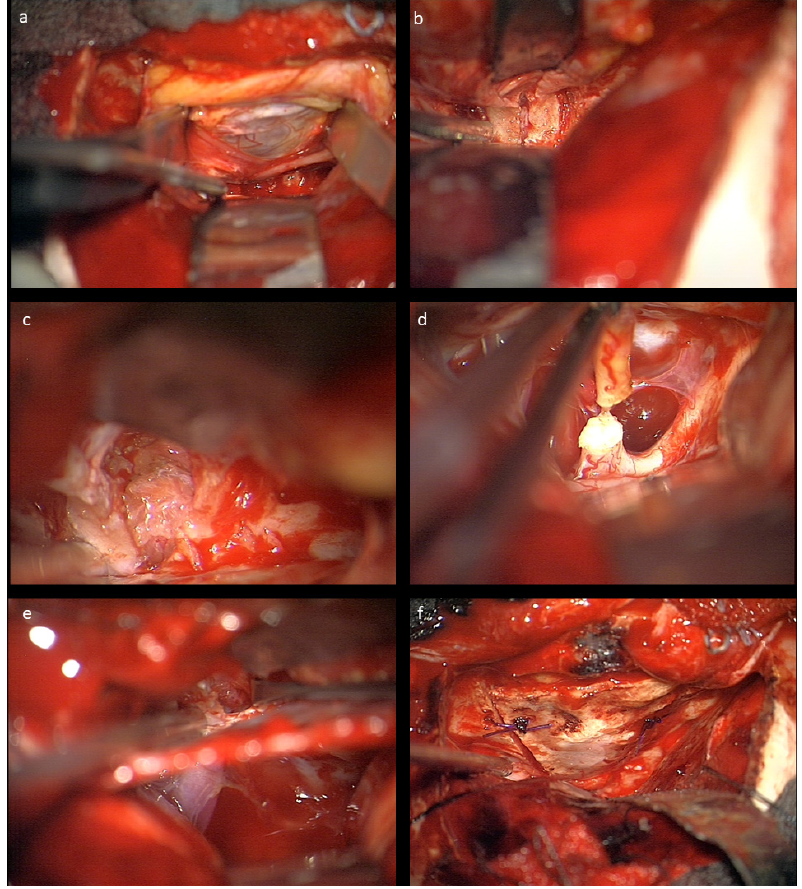
Figure 2. Intraoperative microscopic view after left-sided craniotomy: ( a ) The optic roof was removed and the periorbita is visualized; the frontal nerve (V1) is seen under the retractor. ( b ) The optic canal is visualized extradurally. ( c ) Resection of the glioma in the optic nerve sheath intraorbitally. ( d ) Transection of the optic nerve prechiasmatically. ( e ) Combined intra ‐ and extradural visualization of the optic canal and the intradural space medial to the carotid aretery. At the bottom of the optic canal, the beginning of the ophthalmic artery can be seen. ( f ) Reconstructed orbital roof. In Berlin (Group B), a lateralized eyebrow incision was applied to expose the supra ‐ orbital rim after incision of the orbicularis muscle and periosteal and anterior parts of the temporal muscle dissection. Using a piezosurgery craniotome, a supraorbital mini ‐ crani ‐ otomy was performed by leaving the supraorbital nerve medially intact and including the zygomatic process of the frontal bone. The craniotomy exposed the periorbital as well as the frontal basal dura. After scleral incisions, the rectus muscles were identified and li ‐ gated to achieve control over the muscular structures during tumor resection. The perior ‐ bit was opened, and intraorbital structures were secured as described above. The intraor ‐ bital fat was reduced and retracted to prepare for dissection towards the optic nerve under ultrasound guidance. The optic nerve sheath was opened, and the tumor was debulked by ultrasound aspiration. After sufficient space was gained, the posterior bulbus and the insertion of the optic nerve was identified. The nerve was cut in close proximity to the bulb. Then, the remnants of the nerve and the tumor were dissected towards the orbital cone. Just in front of the optical canal, the most posterior segment of the optic nerve was